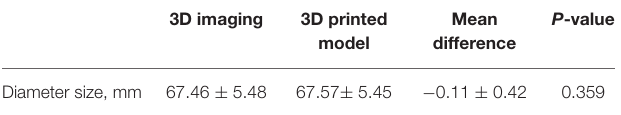
TABLE 2 | Differences in size of left atrium by three-dimensional (3D) images and 3D-printed